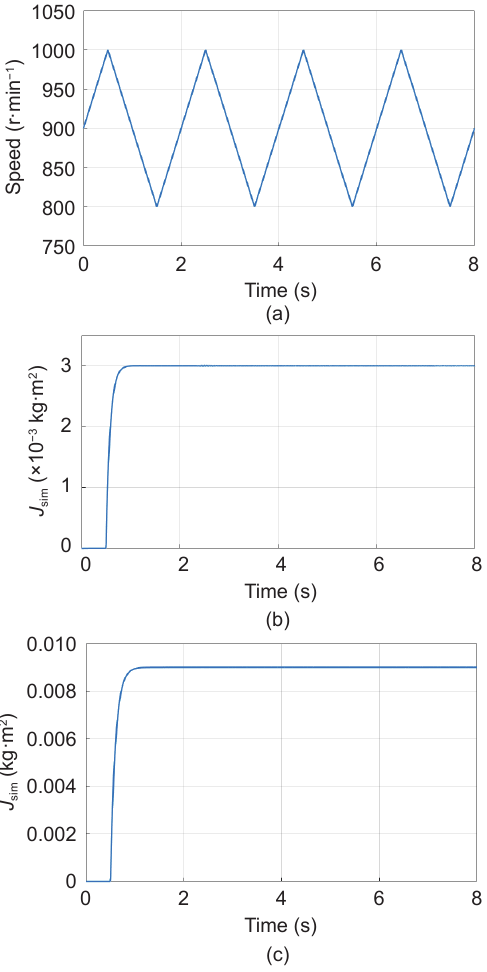
Fig. 10 Viscous friction identification results. (a) Fig. 11 Moment of inertia identification results. (a) Sawtooth wave-like varying speed. (b) J =0.003 kg·m 2 simulation result. (c) J =0.009 kg·m 2 simulation